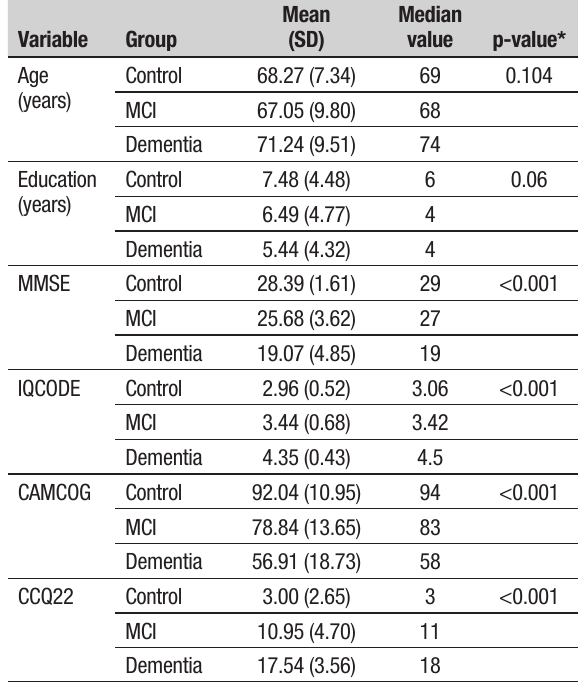
Table 1. Descriptive analysis of the groups (control, MCI, dementia).